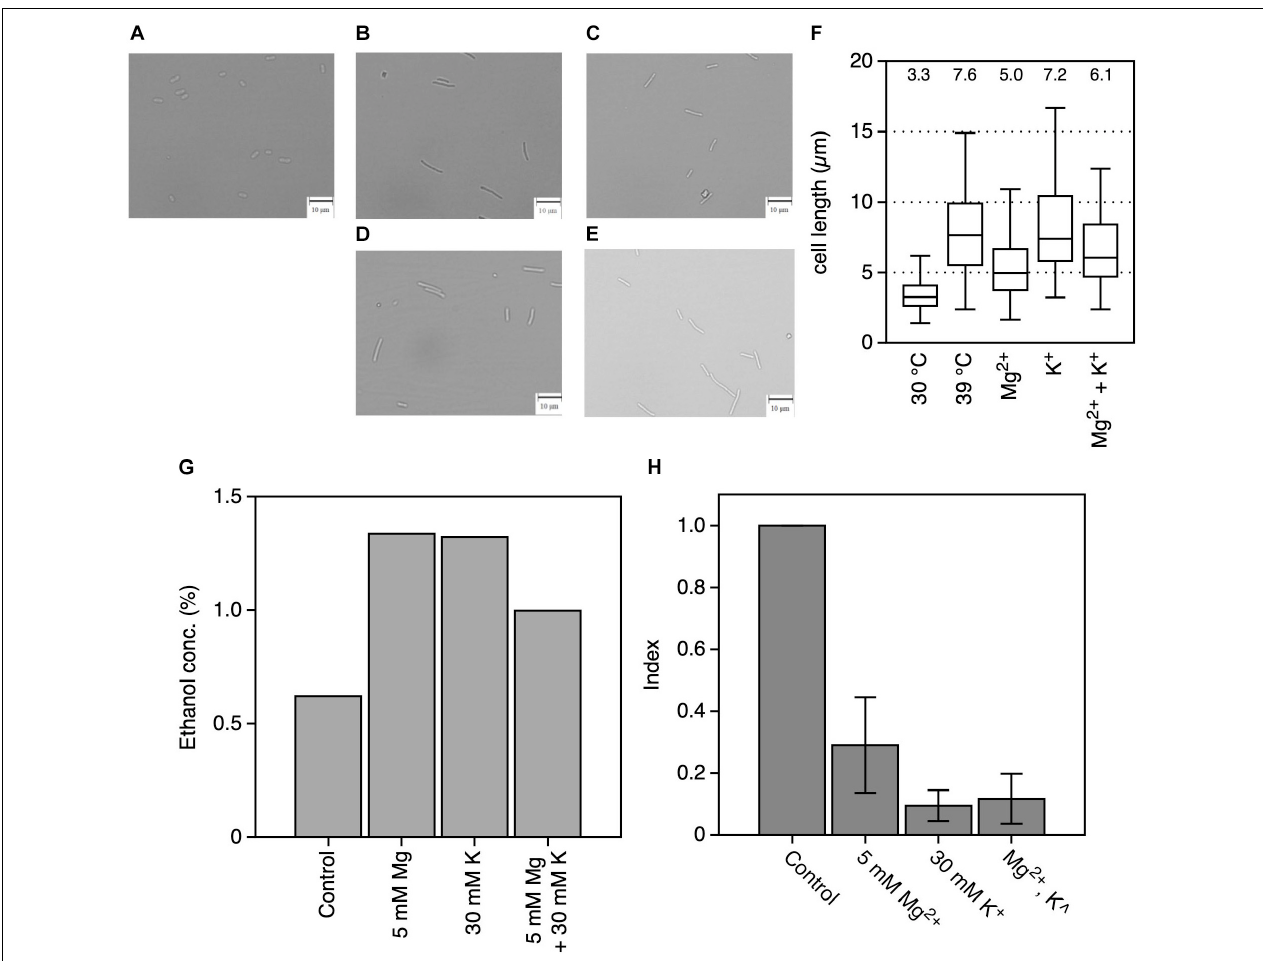
FIGURE 3 | Effects of Mg 2 + and K + on the physiology of Zymomonas mobilis TISTR 548 at critical high temperatures. Under all conditions, the final concentrations of the added MgCl 2 and KCl were 5 and 30 mM, respectively. (A–E) Morphology of cells grown in YPD medium at 30 ◦ C (A) or 39 ◦ C (B) with MgCl 2 (C) , KCl (D) , or both (E) for 7 h under a static condition. Photographs were taken at a magnification of × 400. Bars indicate 10 µ m. (F) A box plot of cell length from 100 cells measured in these conditions. The median cell length under each condition is shown as a number. (G) Ethanol concentration was measured in culture at 39 ◦ C for 12 h in YPD medium under a static condition. (H) The intracellular ROS level was measured in culture at 39 ◦ C for 12 h. Index was calculated as the ratio of the fluorescence intensity and protein concentration to the values of the control. Values and error bars represent means and standard deviations, respectively, for triplicate